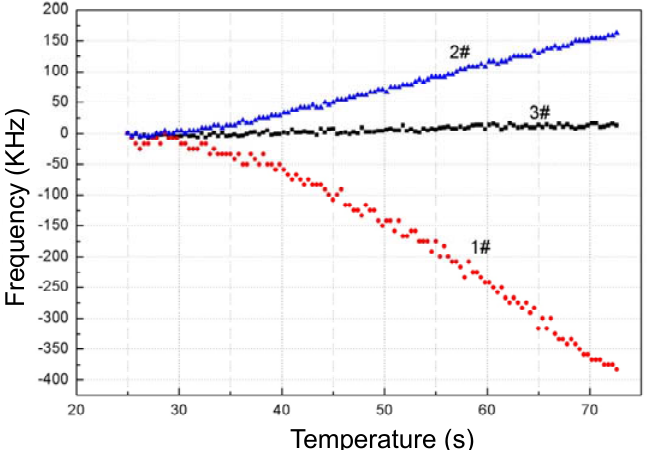
Figure 9. Measured temperature-dependent frequency shift of the devices #1, #2, and #3.